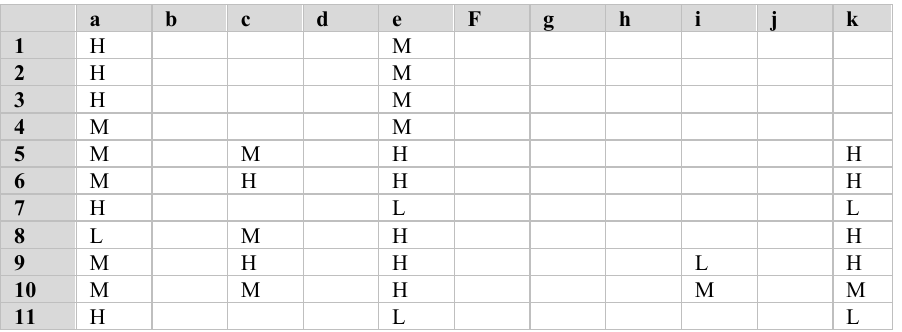
Table 3. Mapping of the Electric Circuits (EC) CLOs (1 through 11) to the SOs (a through k) with the level of